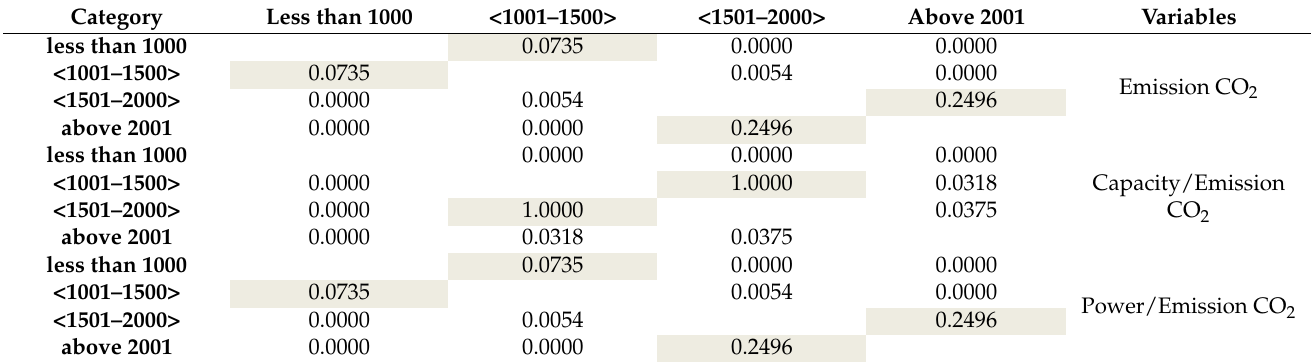
Table 6. p -values for differences in the levels of the variables tested broken down by engine displace- ment categories of cars manufactured in Europe and